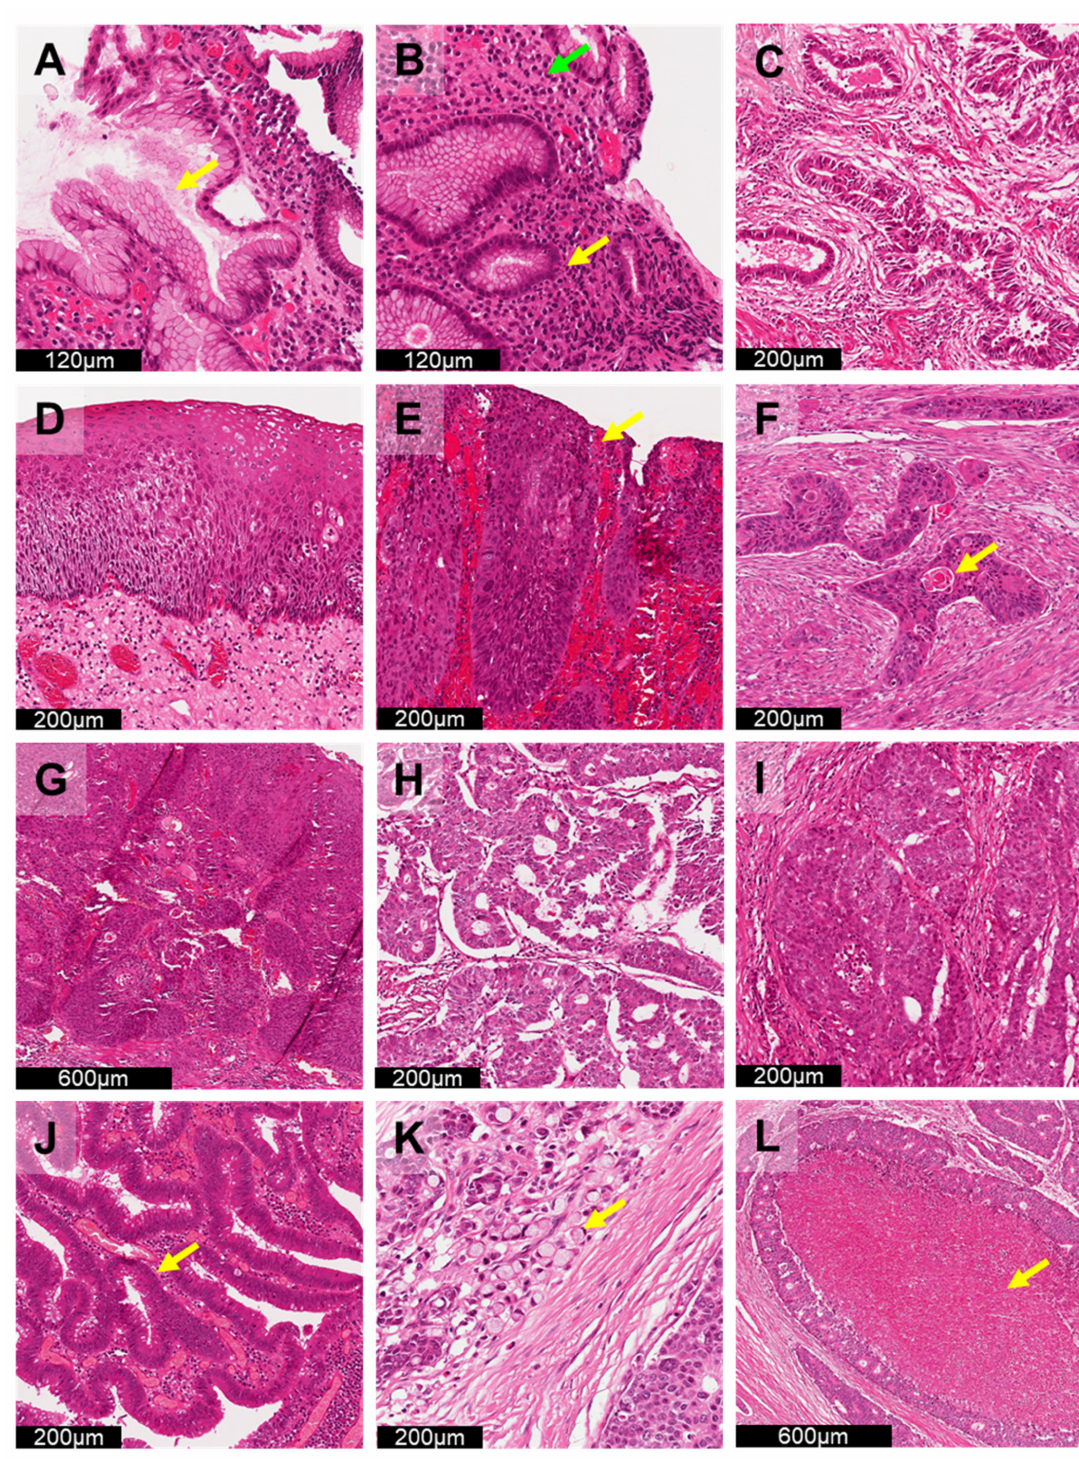
Figure 3. Representative H&E-stained sections of different pathologies along the GI tract. ( A ) Helicobacter-pylori-associated gastritis. Abundant curved rods lining the surface epithelium with underlying mixed inflammatory infiltrate. ( B ) Moderate number of plasma cells (green arrow), indicating chronic inflammation, and neutrophils (yellow arrow), indicating active inflammation. ( C ) Gastric adenocarcinoma. Irregular angulated glands lined by tumour cells with enlarged hyper- chromatic nuclei, moderate nuclear pleomorphism and frequent mitotic figures. The